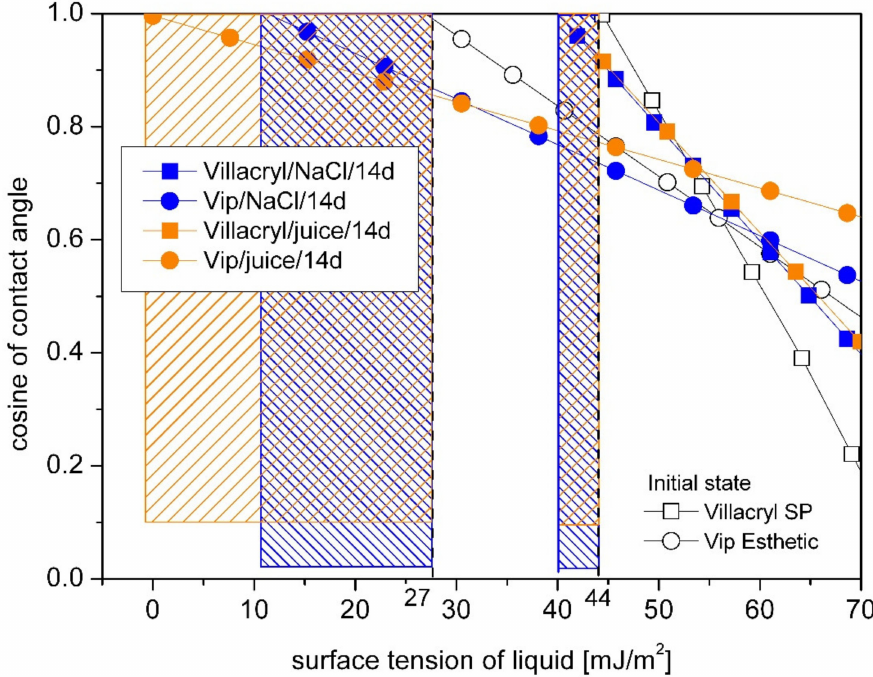
Figure 6. Comparison of time storage and medium type influence on the critical surface free energy (marked with vertical lines) for Vip Esthetic and Villacryl SP dental materials obtained by Zisman’s method. The hatched area shows the difference of γ C between samples in the initial state and after